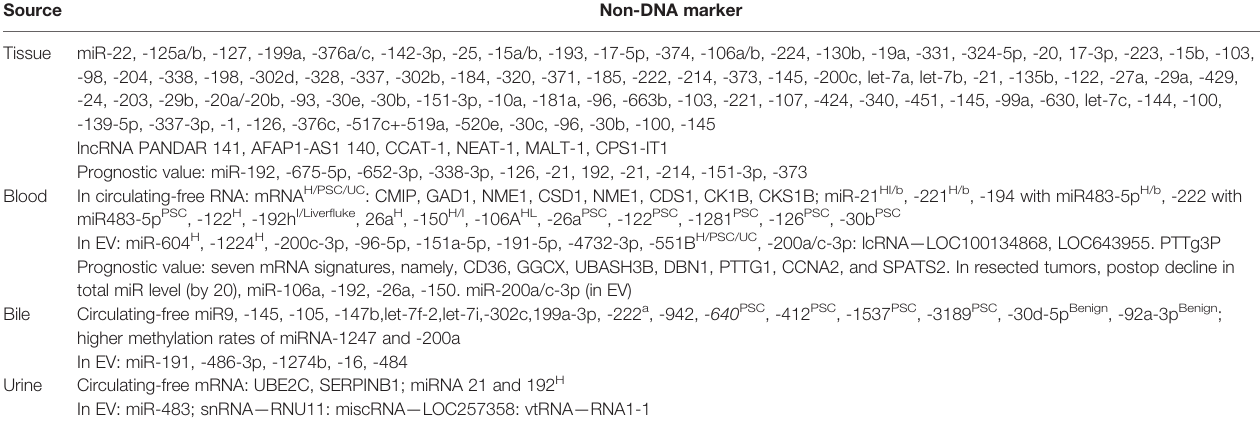
TABLE 3 | Non-DNA markers in biliary tract